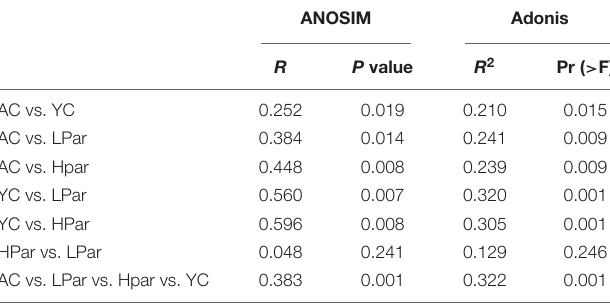
TABLE 1 | Analysis of similarities (ANOSIM) and Adonis analysis results based on Bray–Curtis dissimilarity (permutations =